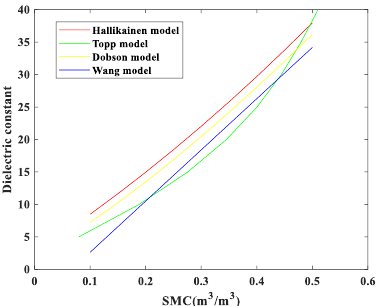
Figure 7 . The four soil models on international sandy clay loam （ C=0.2 ， S=0.7 ） .